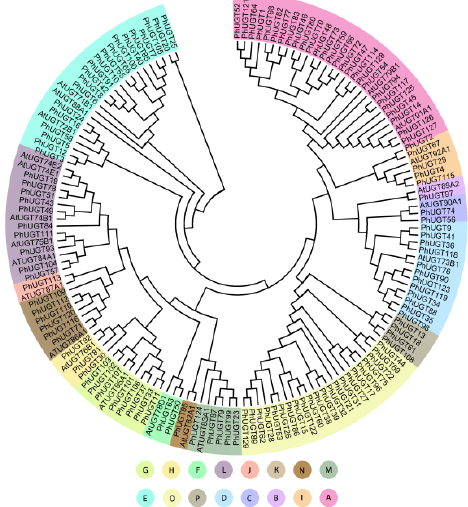
Figure 1. Phylogenetic tree of the UGT